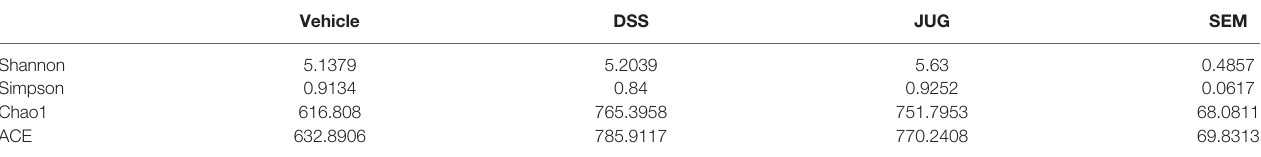
TABLE 1 | Alpha diversity indexes of each